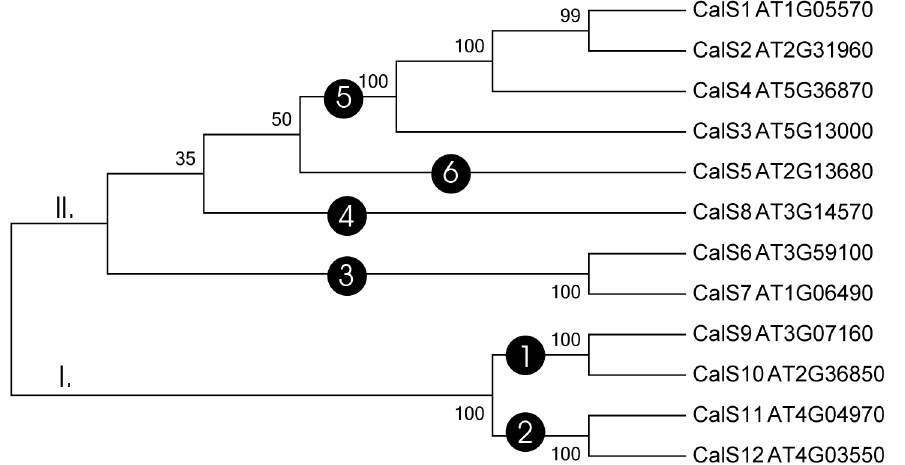
Fig 1. Phylogenetic tree of 12 Arabidopsis thaliana callose synthases. The evolutionaryhistory was inferred using maximum likelihood. The bootstrapsupport values are shown next to the branches. Accessions are listed in Table